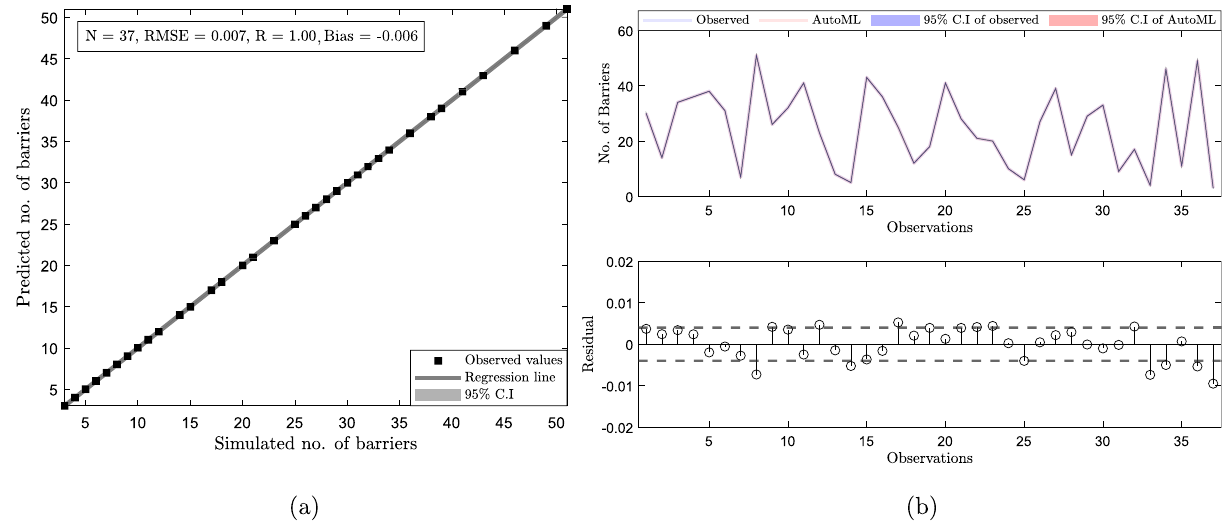
Figure 5. The left panel shows the linear regression plot between the predicted and observed responses. The top plot on the right panel shows the time series plot of the predicted and observed. The bottom panel shows the corresponding residuals. The dashed line in the residual plot shows the RMSE value.